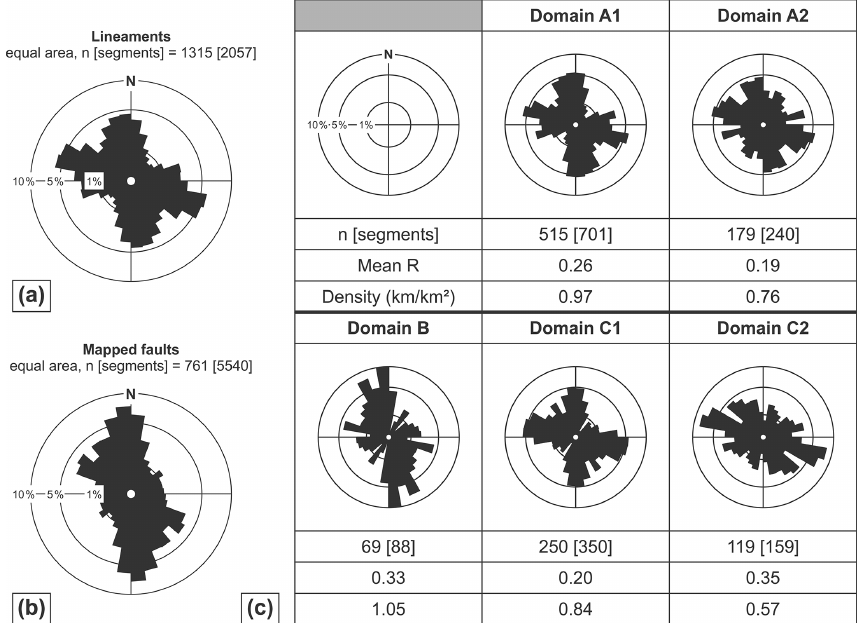
Figure 8. Rose diagrams of (a) lineaments detected in the DEM and (b) inferred faults from geological maps. (c) Statistical analysis of the detected lineaments carried out separately for each of the five defined domains. The analysis includes rose diagrams as well as calculations regarding the statistical scatter (mean resultant) and the mean spatial density of the lineaments. The mean resultant (Mean R) is a measure of dispersion analogous to the variance but expressed in the opposite sense. Lower values indicate a more dispersed distribution or the presence of different individual peaks, whereas higher values indicate that the observations are tightly bunched together (Davis, 2002). Only lineaments outside of a 2km buffer along the domain boundaries were considered in the analysis to avoid biases related to the trends and lengths of the major fault zones and associated lineaments. Note that the Bodenwöhr Trough in domain A2 and the Cham Basin in domain B (see Fig. 6) have been excluded from the analysis due to their sedimentary infill. All rose diagrams have been length-weighted and calculated using a bin size of 10 ◦ . Lineaments and faults have been segmented prior to statistical